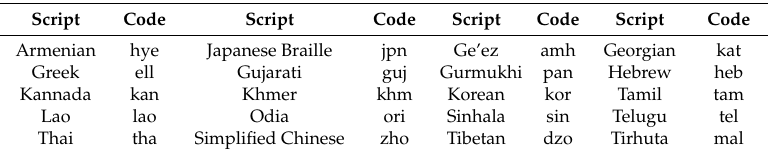
Table 1. Script datasets with only one member.